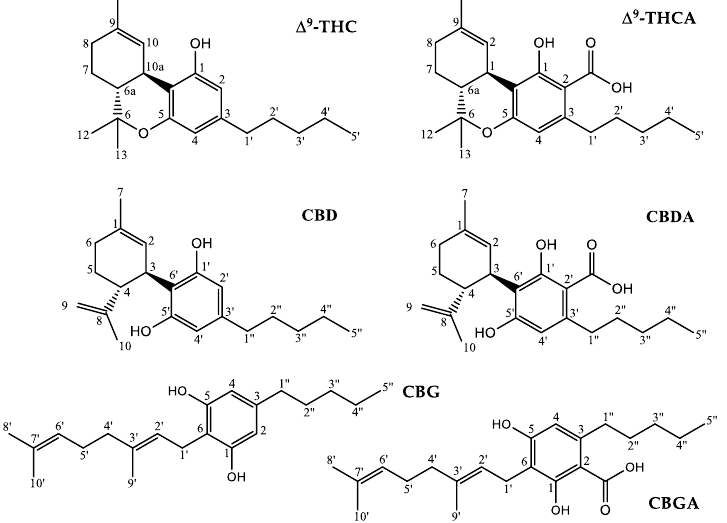
Figure 1. Chemical structure and nuclei numbering of molecular fragments in hemp principal can-